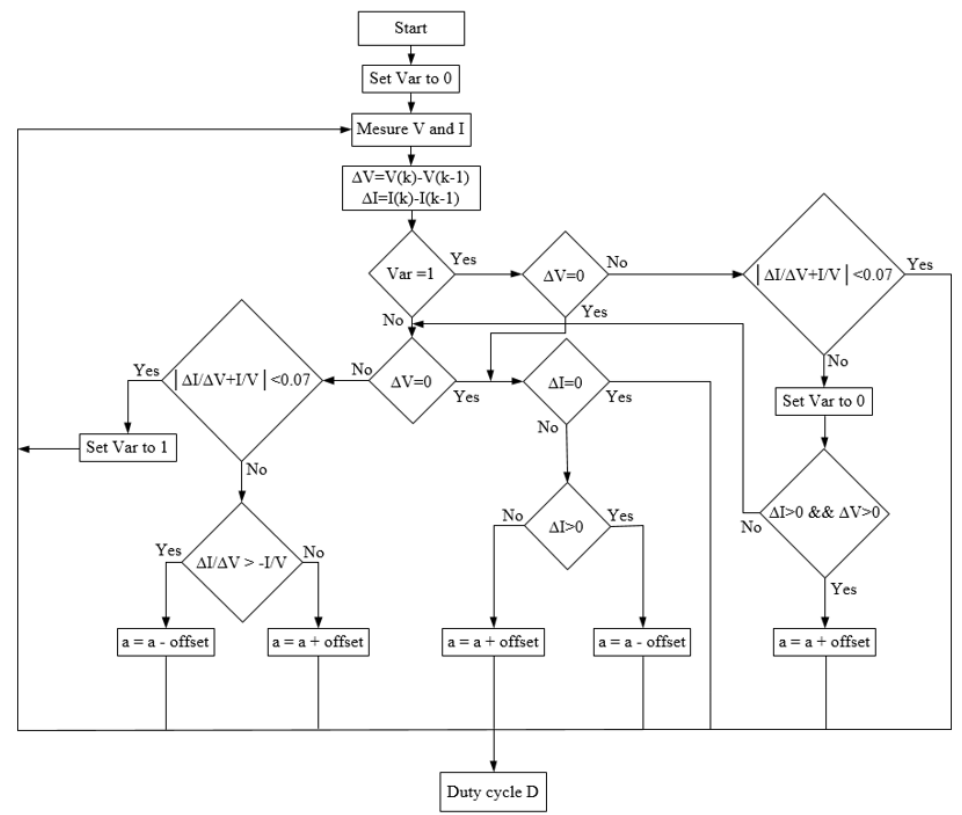
Figure 10. MIC flowchart diagram.